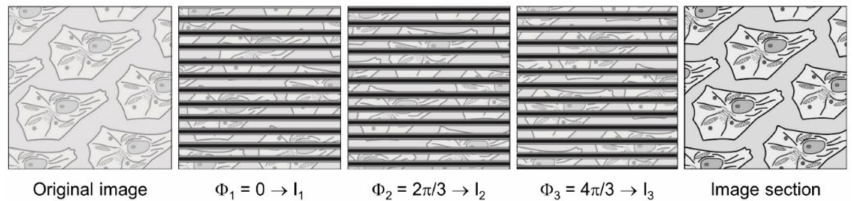
Figure 1. Principle of Optical-Sectioning Structured Illumination Microscopy (OS-SIM).